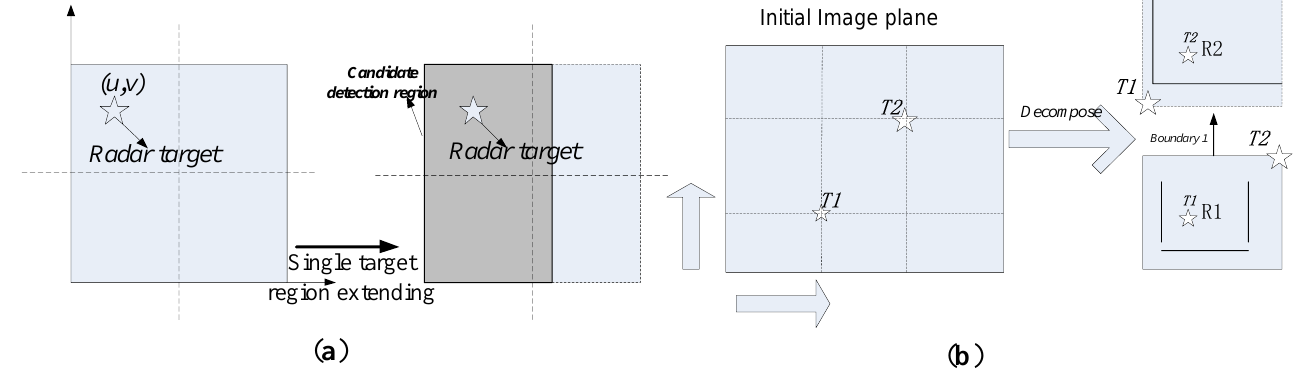
Figure 6. ( a ) Determination of the candidate region for single target detection; ( b ) Determination of candidate regions for two target